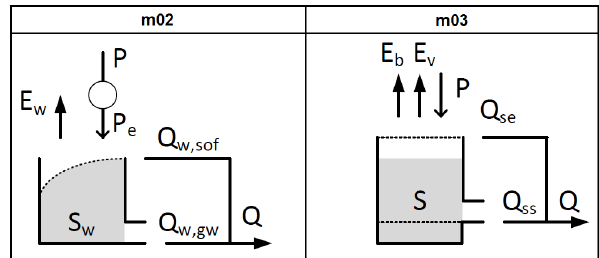
Figure 2. Wiring schematics of MARRMoT models m02 and m03 selected for this teaching module. Schematics are reproduced from Figs. S2 and S3 in the Supplement of Knoben et al. (2019a) un- der CC BY 4.0. More in-depth model descriptions can also be found in this Supplement. Students are directed to these descriptions as part of Exercise